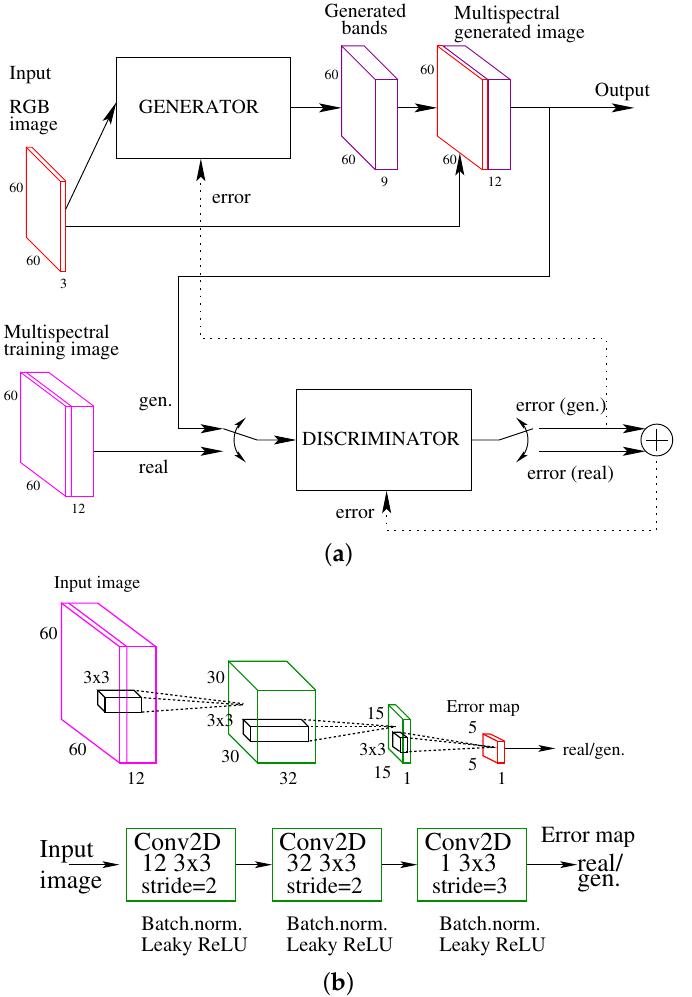
Figure 3. Conditional Generative Adversarial Network architecture: ( a ) CGAN overview, ( b ) Dis- criminator model.